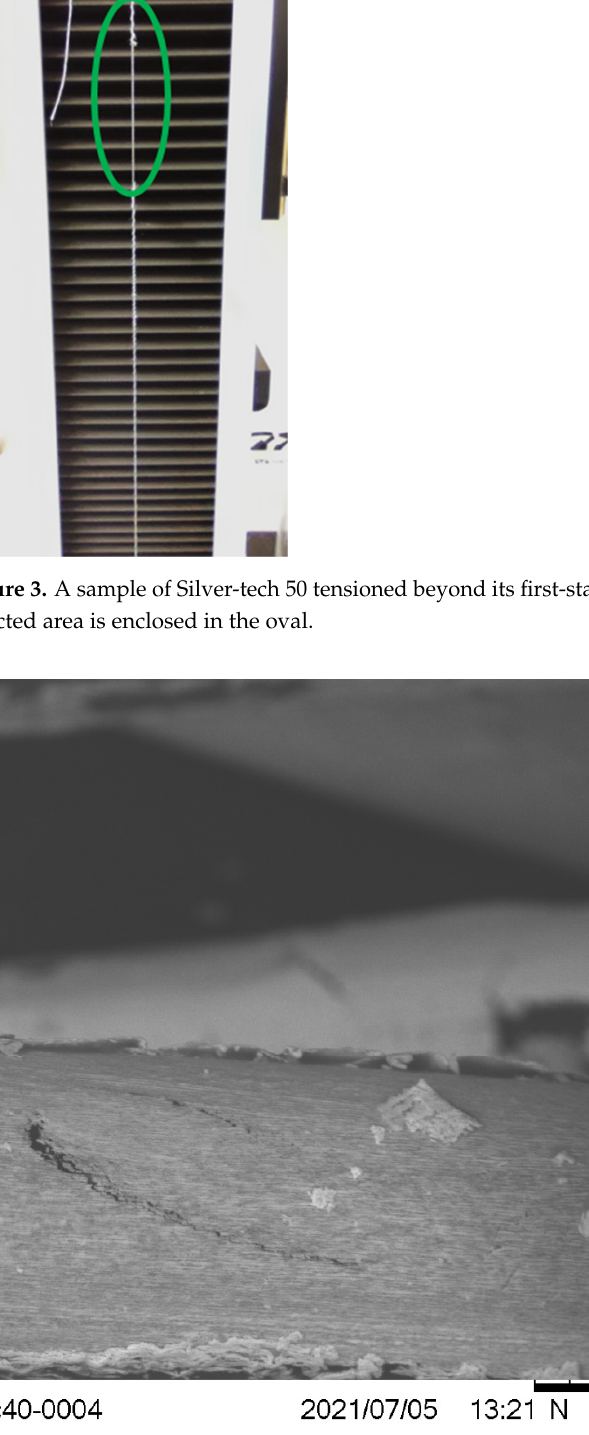
Figure 4. A sample of HC 40 post-fracture. The silver coating is severely damaged but not entirely released from the polymer core, except at breaking point.